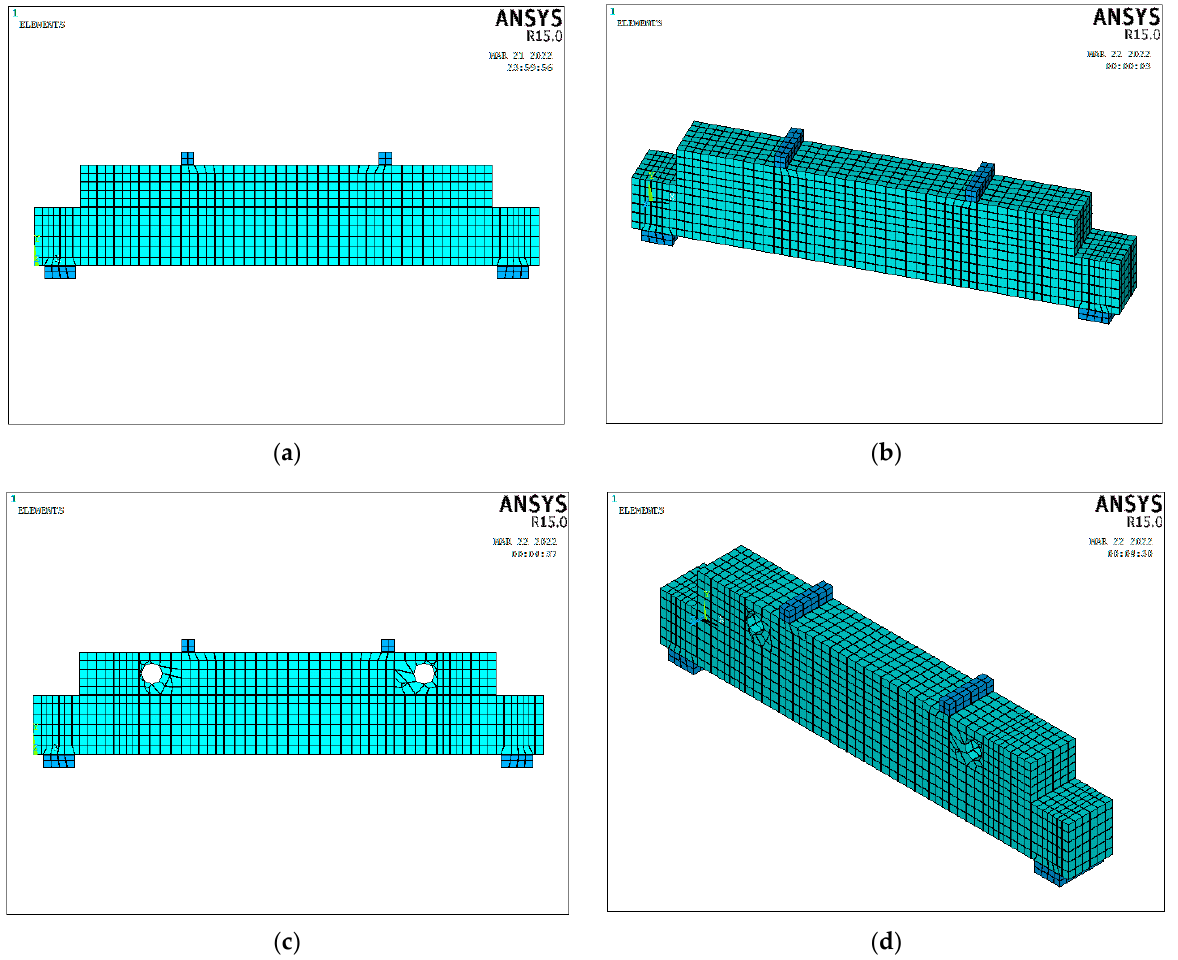
Figure 10. Details of the meshing process for typical RC girder models with dapped ends. ( a ) Front view of the solid model. ( b ) 3D view of the solid model. ( c ) Front view of the model with openings. ( d ) 3D view of the model with openings.